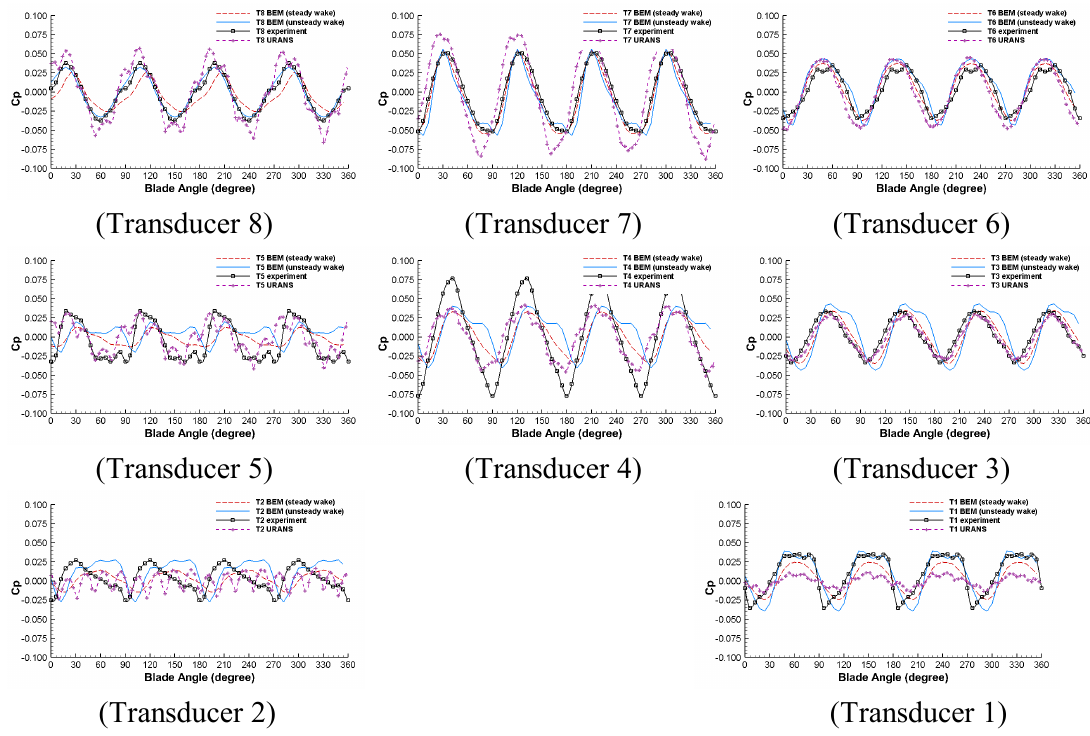
Figure 11. Comparison among the experimental pressure data, Unsteady Reynolds-averaged Navier-Stokes (URANS) method pressure history, and the pressure history predicted by pressure-BEM solver with either a steady or an unsteady wake.